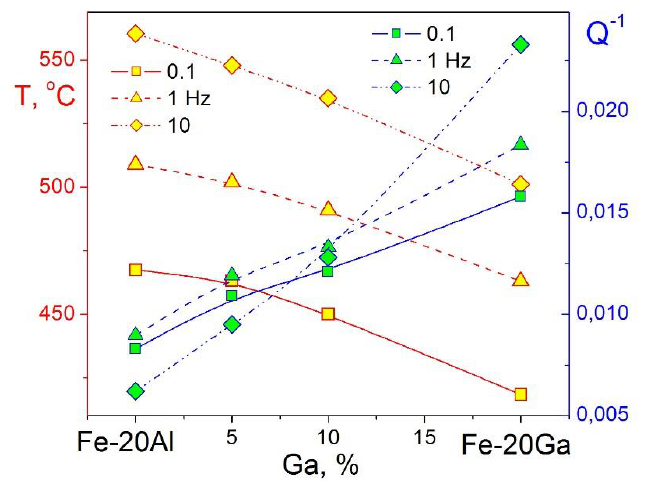
Figure 24. Zener peak temperature and height in Fe–20%(Al+Ga) alloys for measurements at three different frequencies.